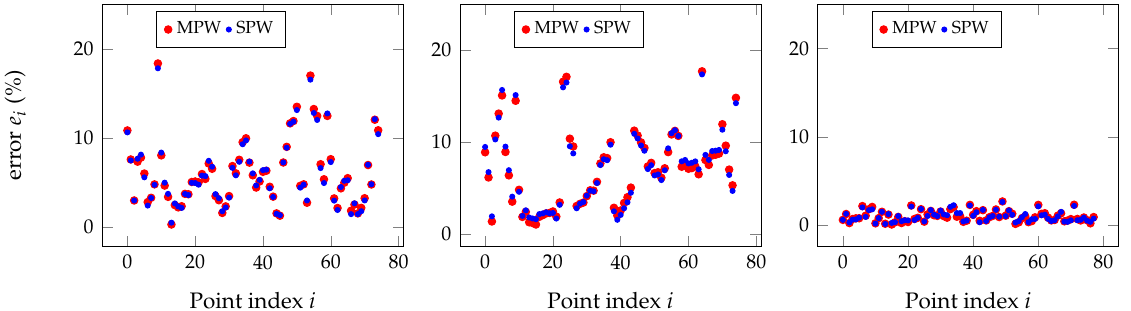
Figure 15. RMS errors for SPW and MPW for the three sensors relative to the reference sensor for the point clouds whose results are shown in Figure 14 but where outliers have been removed by Chauvenet criterion. Number of removed outliers varies with the combination of